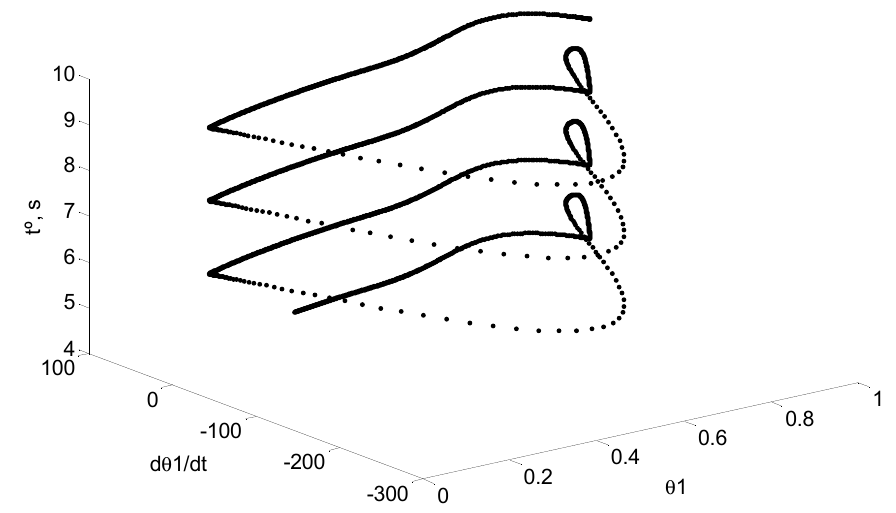
Figure 15. Phase space of carbon monoxide superficial fractional coverage at P 1 = 140 Pa and time step = 10 − 4 s.